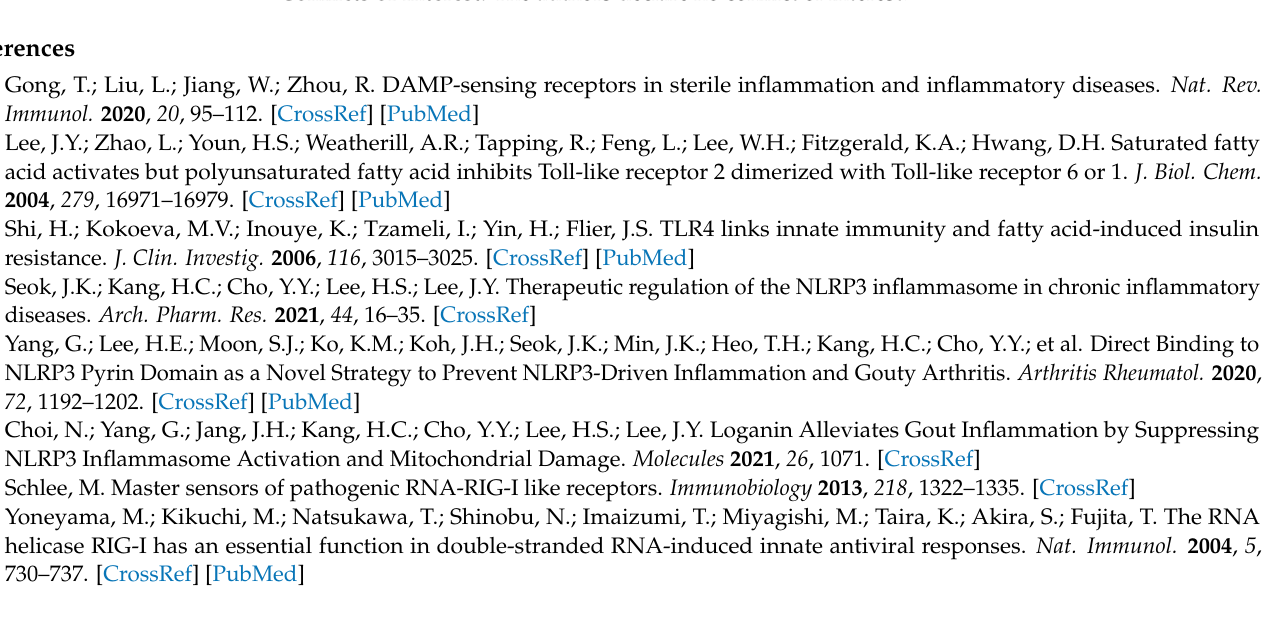
wild-type (WT), RIG-I knockout (KO), or MDA5 KO mice fed normal diet (ND) or high fat diet (HFD); Figure S3: RIG-I expression in primary hepatocytes isolated from wild-type (WT) or RIG-I-knockout (KO) mice; Figure S4: Hepatic IFN- α and IFN- β levels of wild-type (WT), RIG-I knockout (KO), or MDA5 KO mice fed normal diet (ND) or high fat diet (HFD); Figure S5: RIG-I expression in livers isolated from of wild-type mice fed normal diet (ND) or high fat diet